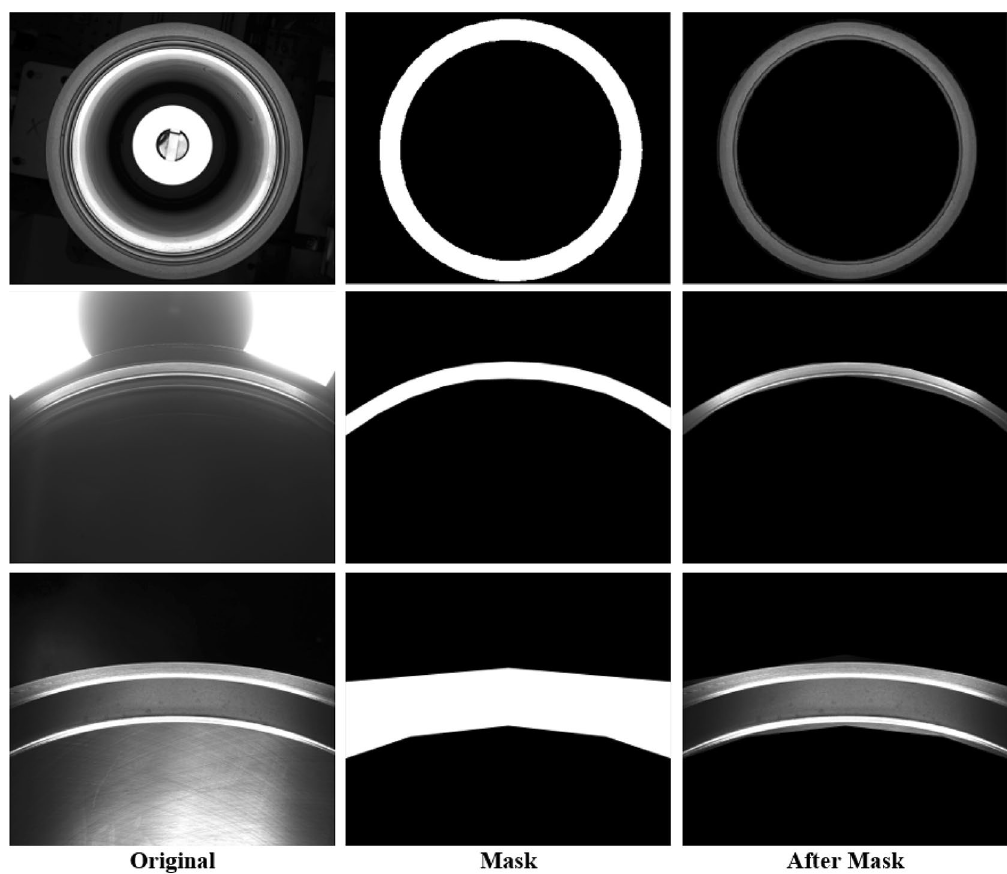
Figure 8. Our proposed mask mechanism for cylinder liner.